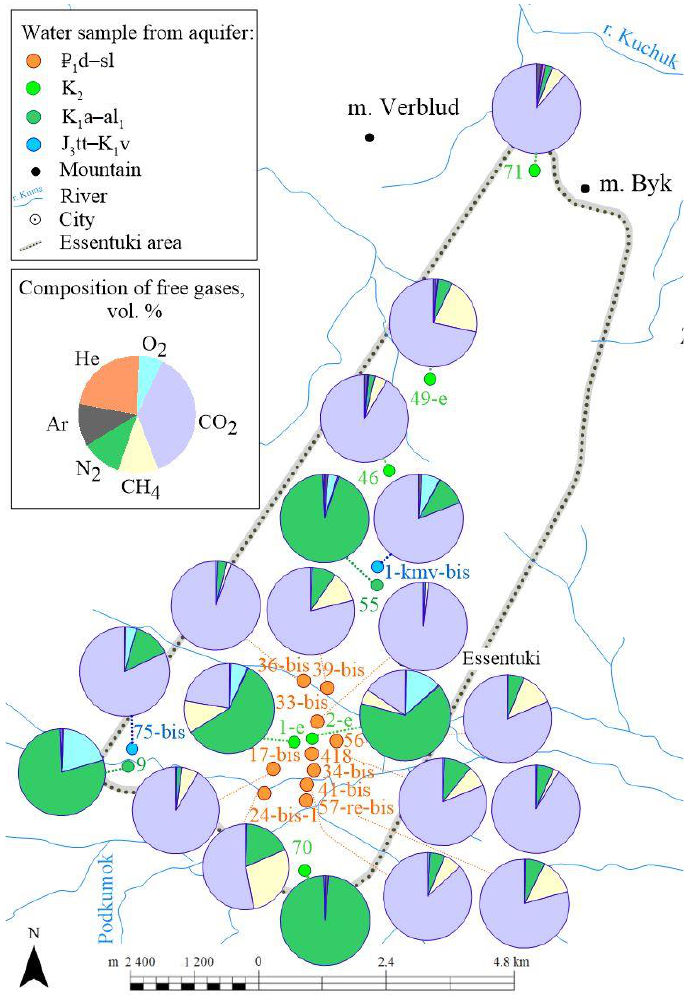
Figure 12. Gas composition of natural mineral water of the Essentuki field. Table 5. Chemical composition of free gases of natural mineral water of the Essentuki field.